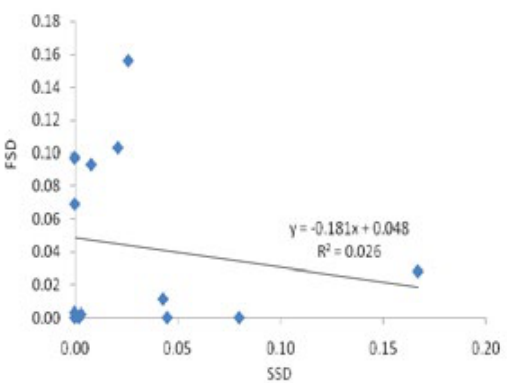
Fig. 5: Correlation between OC levels in FS D and SS D